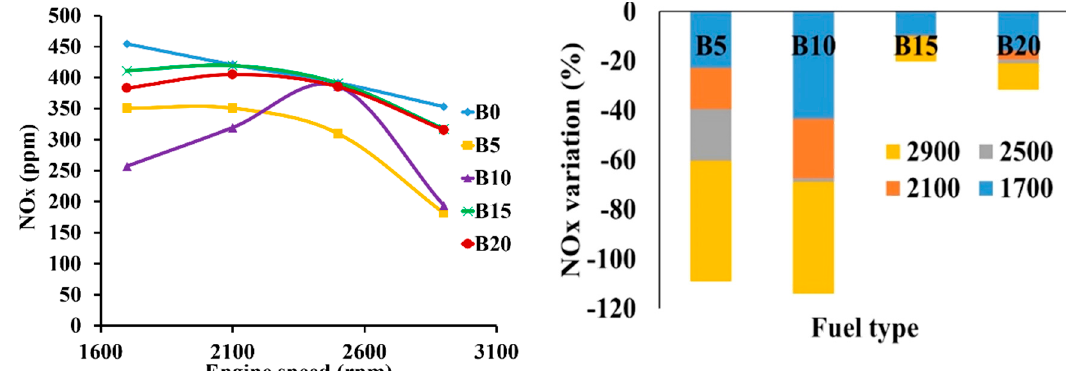
Figure 17. Variation of NOx (ppm) for different engine speeds and diesel biodiesel blends at full load.